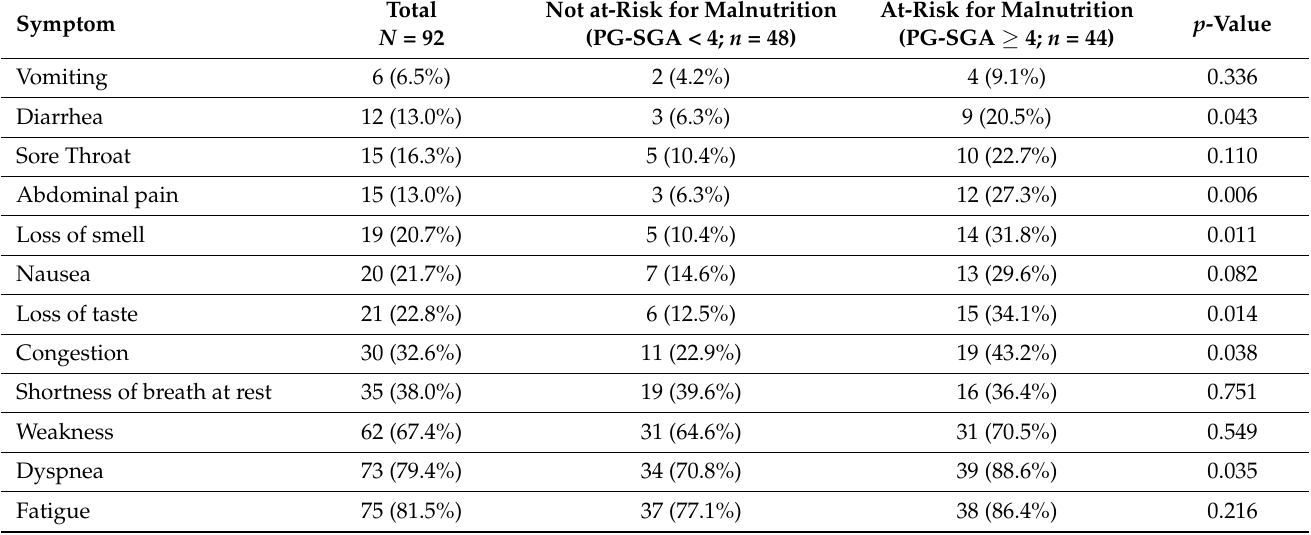
Table 2. Symptoms of final sample by malnutrition risk ( n =